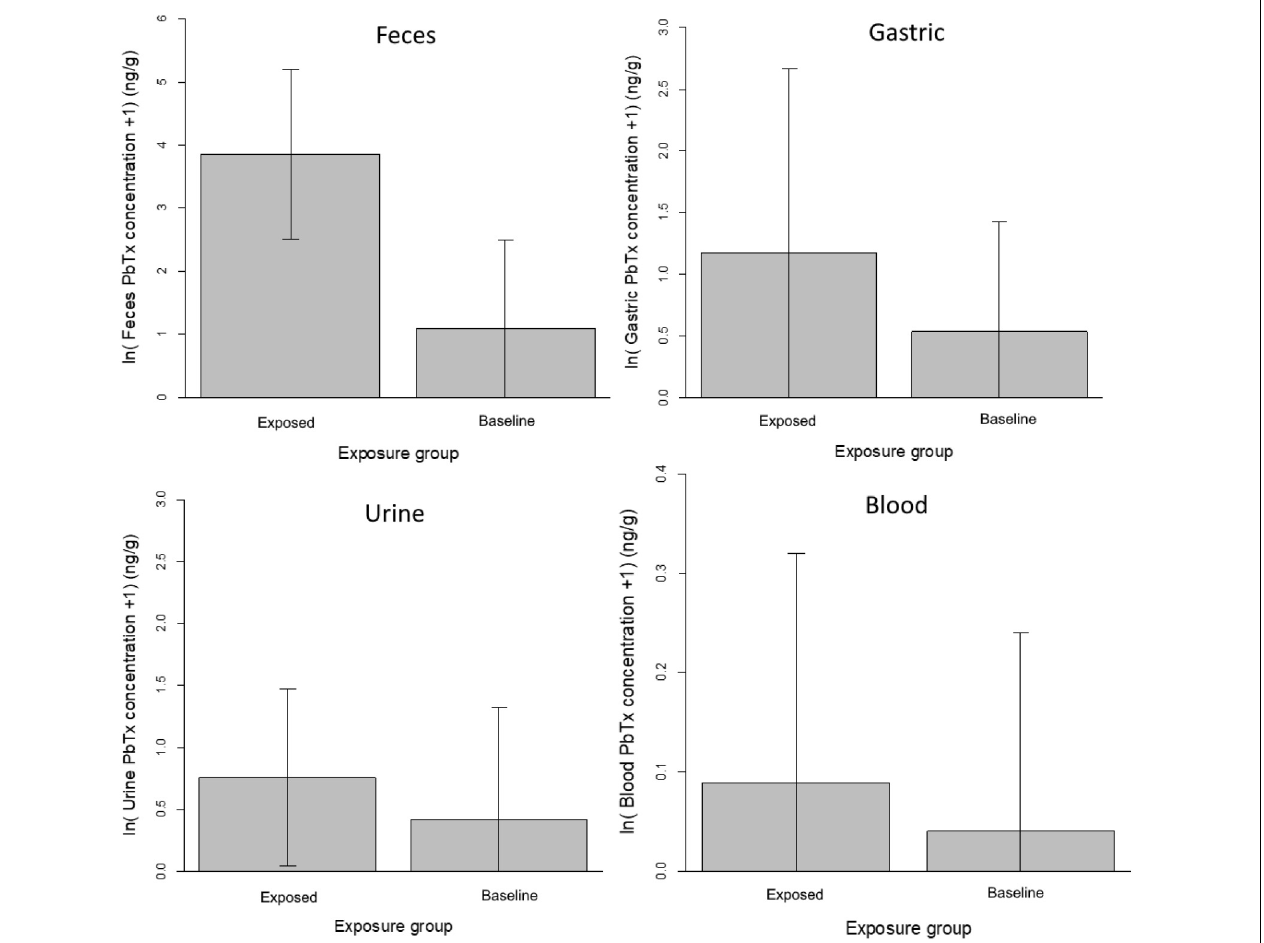
FIGURE 1 | Comparison of PbTx concentrations by sample